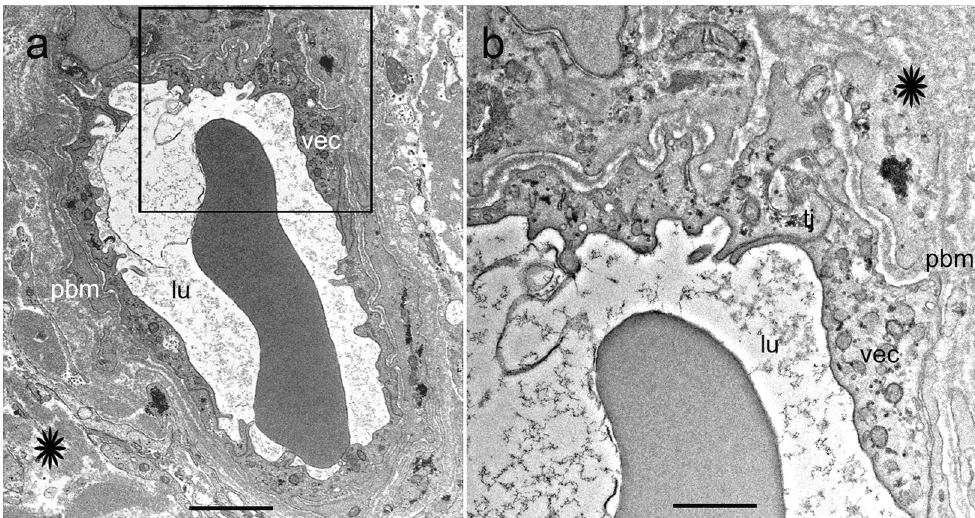
Figure 1. The BLB in normal capillaries. Capillary located in the stroma of the macula utricle from a normal subject (62-year-old male). ( a ) Low magnification view. The lumen (lu) of the capillary is smooth and vascular endothelial cells (vec) exhibit normal morphology. The perivascular basement membrane (pbm) and extracellular matrix (asterisk) are also normal. ( b ) high magnification view from ( a ), vec show normal cytoplasm. Tight junctions show a normal organization (tj). Bar ( a ) = 2 μ m, ( b ) = 300